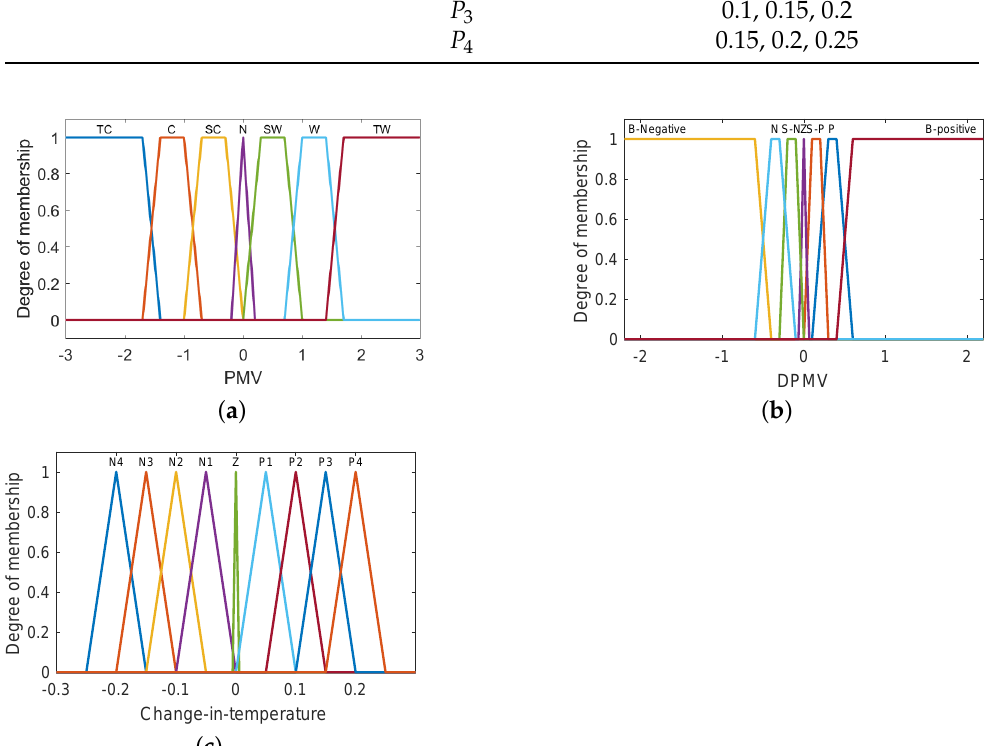
Figure 4. Membership functions of the ( a ) first input (PMV), ( b ) second input ( ∆ PMV) and ( c ) output of the fuzzy temperature